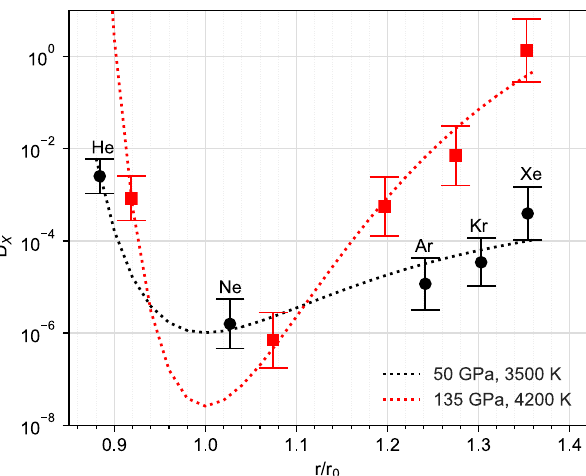
Fig. 2 Partition coef fi cients of noble gases from calculations and the liquid-melt partition model. Partition coef fi cients (concentration in weight) of noble gases between liquid Fe and silicate melt at 50 GPa, 3500 K and 135 GPa, 4200 K, plotted against the bond-length ratio of Mg – X to Mg – O (denoted as r and r 0 ). Filled circles and squares are our calculated data from ab initio thermodynamics and the lines are from fi tting the Lennard-Jones model. Fitted parameters can be found in Supplementary